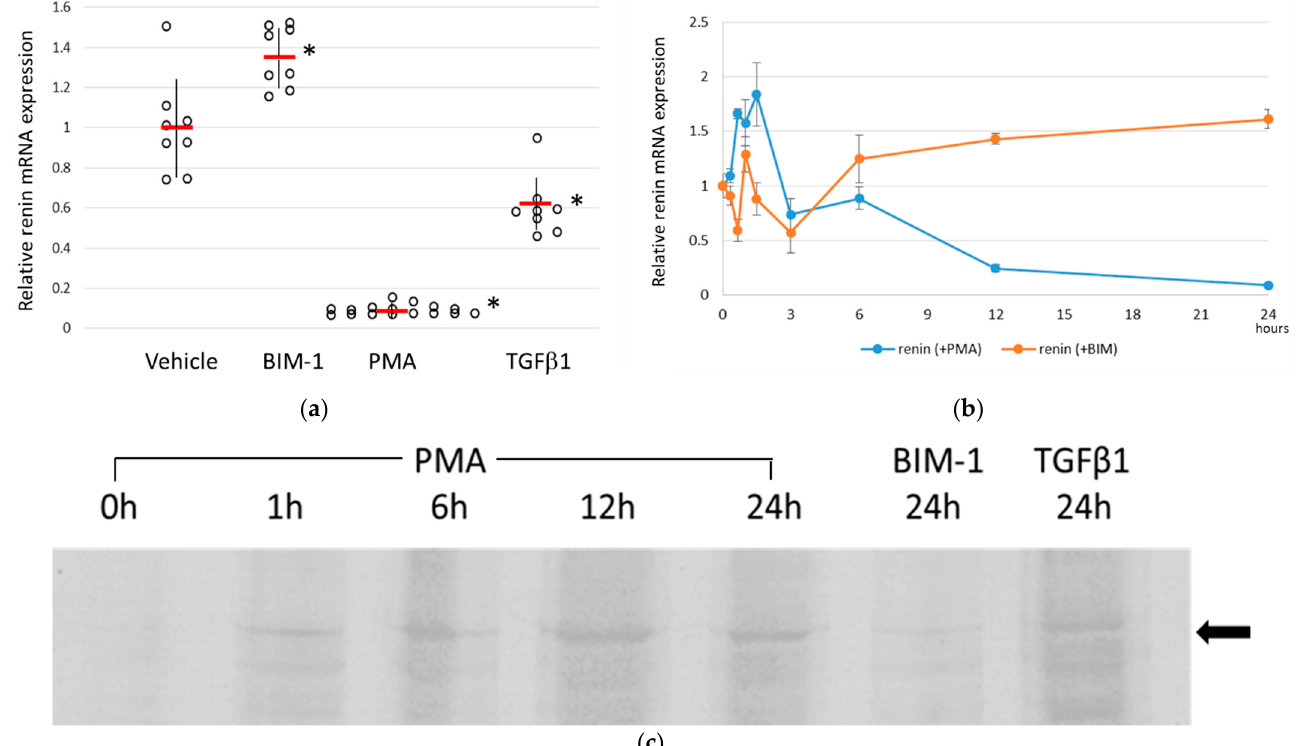
Figure 1. Phosphorylation/dephosphorylation of Thr788/789 of β 1-integrin effect on the renin expression in a juxtaglomerular cell line As4.1. ( a ) Two µ M BIM-1, 50 ng/mL PMA and 1 ng/mL TGF- β 1 were added to the culture of As4.1 cells for 24 h. The renin expression levels were examined by qRT-PCR, and the expression levels relative to control (vehicle) were represented by scatter plot with the average (red bars) and SD (black vertical lines). Significant differences ( p < 0.05) from the control were indicated with asterisks. ( b ) The renin mRNA expression in As4.1 cells cultured with 2 μ M BIM-1 (orange) or 50 ng/mL PMA (blue) in 24 h time-course measured by qRT-PCR. Each point was the average of at least 4 samples. ( c ) Detection of phosphorylation/dephosphorylation of Thr788/789 of β 1-integrin in As4.1 cells. Cells were cultured with 50 ng/mL PMA (for 1, 6, 12, and 24 h, 2 μ M BIM-1 for 24 h or 1 ng/mL TGF- β 1 for 24 h. Phosphorylated phosphor-Thr788/789 in β 1-integrin was detected by a specific antibody. The side arrow represents the position of phospho-Thr788/789 β 1-integrin bands.